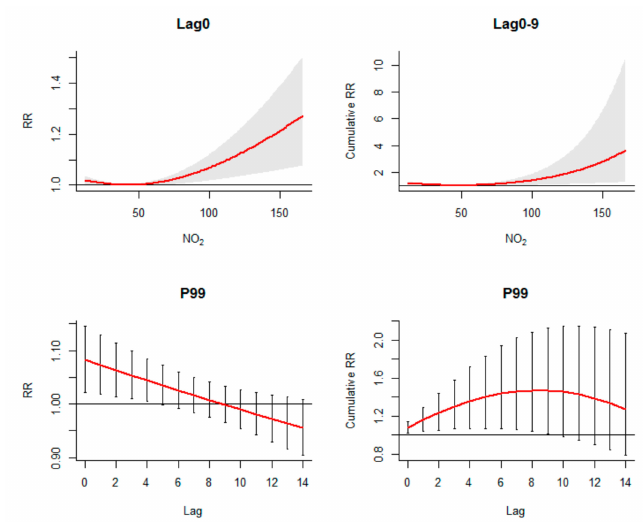
Figure 5. The exposure–response curves of NO 2 over lag 0 and lag 0–9; lag–response curves for 99th percentile of NO 2 (106.1 µ g / m 3 ), calculating single-lag e ff ect and cumulative e ff ect